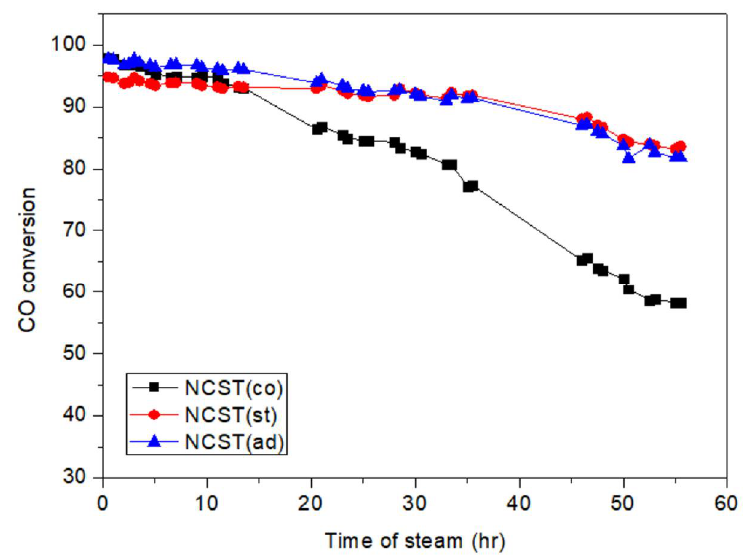
Figure 2. Stability test of result for sample NCTS(co), NCTS(ad) and NCTS(st), reaction condition: H 2 /CO = 3, T = 300 °C, GHSV = 7500 h −1 , atmospheric pressure.